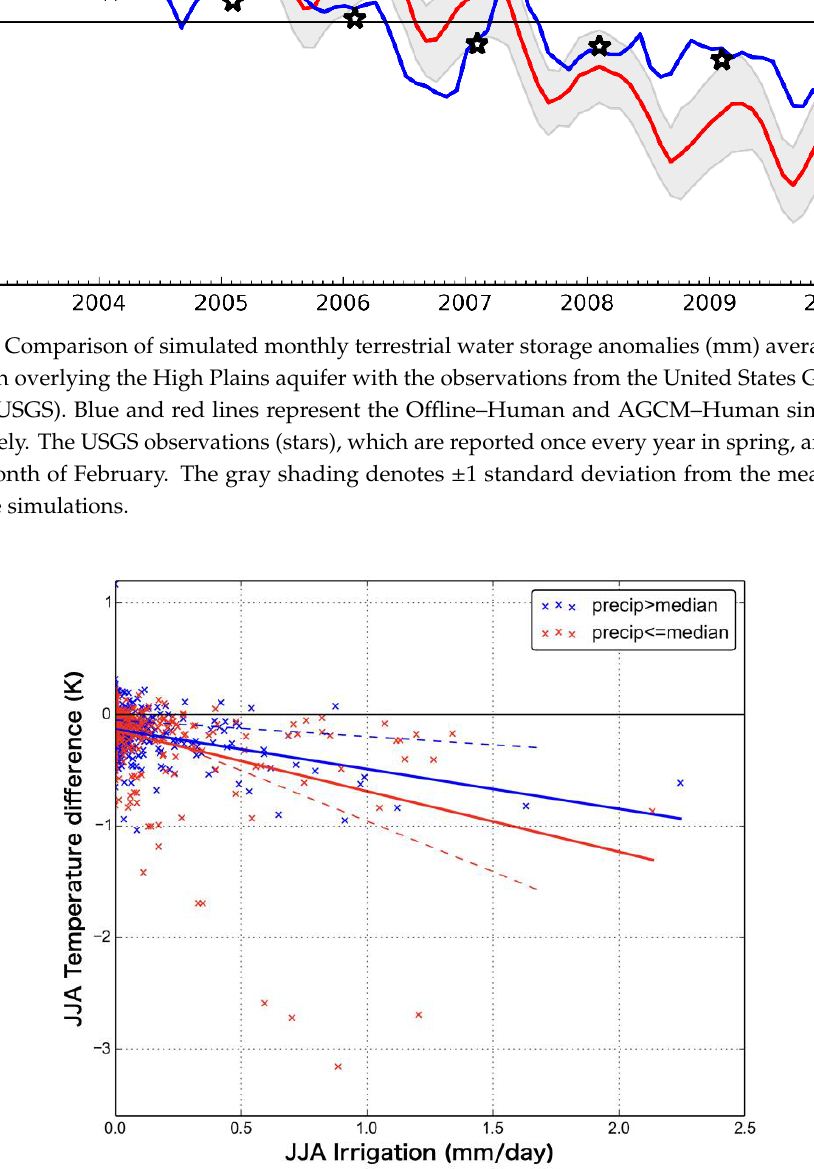
Figure 3. Differences in JJA near surface air temperature between AGCM-Human and AGCM-ORG simulations as a function of JJA irrigation amount. The relationship is separated into points with precipitation greater than the median (blue crosses) and with precipitation less than the median (red crosses) following Sacks et al. [23]. Blue and red solid lines denote regression lines for large (blue crosses) and small (red crosses) precipitation grid cells, respectively; the dashed lines with the same colors show the results from Sacks et al. [23].